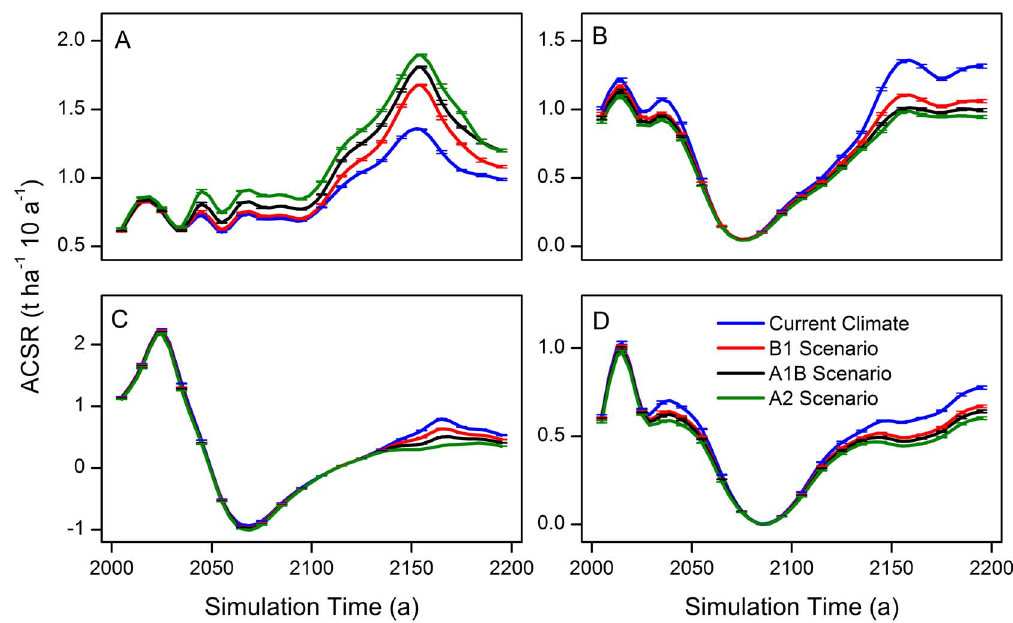
Figure 3. Forest aboveground carbon sequestration rates of four conifers. A: Korean pine, B: Spruce, C: Khingan fir, and D: Larch.